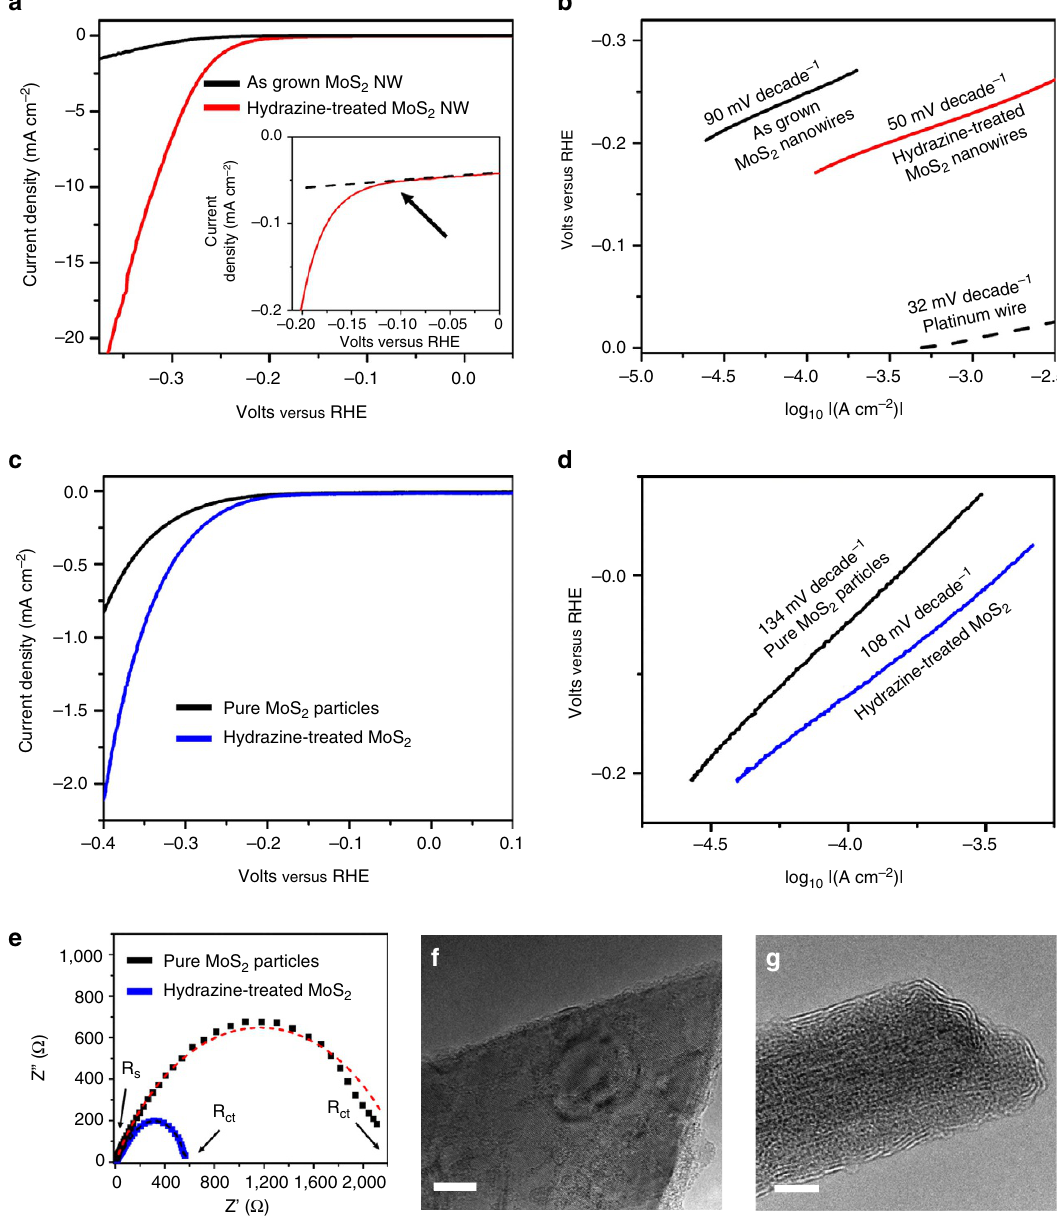
Figure 2 | Electrochemical analysis of MoO x /MoS 2 core-shell nanowires and MoS 2 particles. ( a ) Linear sweep voltammetry for as-grown MoO x /MoS 2 core-shell nanowire (black curve) and after exposure to 1% Hydrazine (red curve). ( b ) Tafel slopes for as-grown MoO x /MoS 2 core-shell nanowires (black curve), 1% hydrazine-treated nanowires (red curve), and a platinum wire (dotted black curve). ( c ) Linear voltammograms and corresponding ( d ) Tafel slope analysis of MoS 2 particles before (black curve) and following exposure to dilute hydrazine (blue curve). ( e ) Electrochemical impedance spectroscopy (EIS) Nyquist plots of the MoS 2 particles following exposure to hydrazine, with line fits shown by dotted lines. ( f ) High-resolution TEM (HRTEM) of 2H-MoS 2 particle. Scale bar, 5nm. ( g ) HRTEM of as-grown MoO x /MoS 2 core-shell nanowire. Scale bar, 10nm. NATURE COMMUNICATIONS|7:11857|DOI: